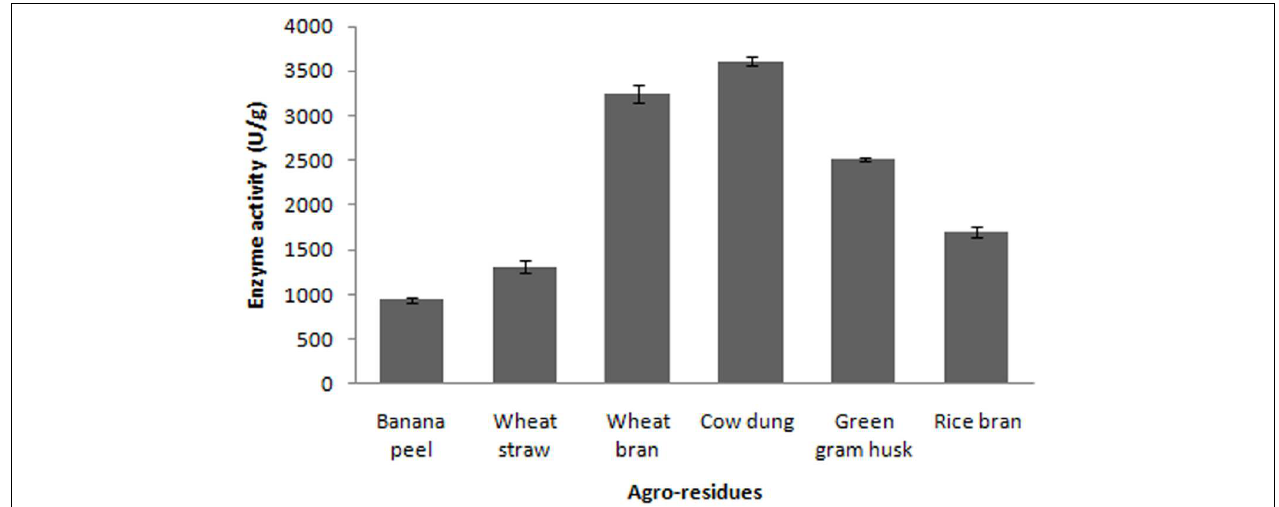
FIGURE 2 | Screening of agroindustrial wastes for the production of fibrinolytic enzyme.